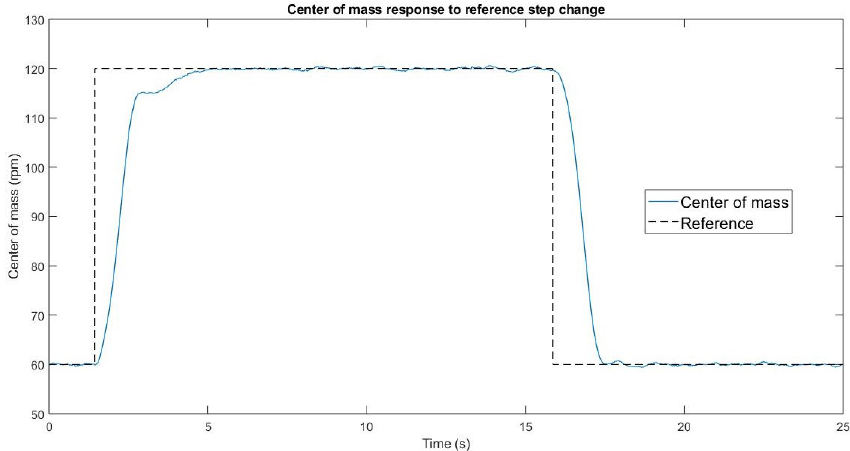
Figure 5. Experimental control outputs with a reference step change.